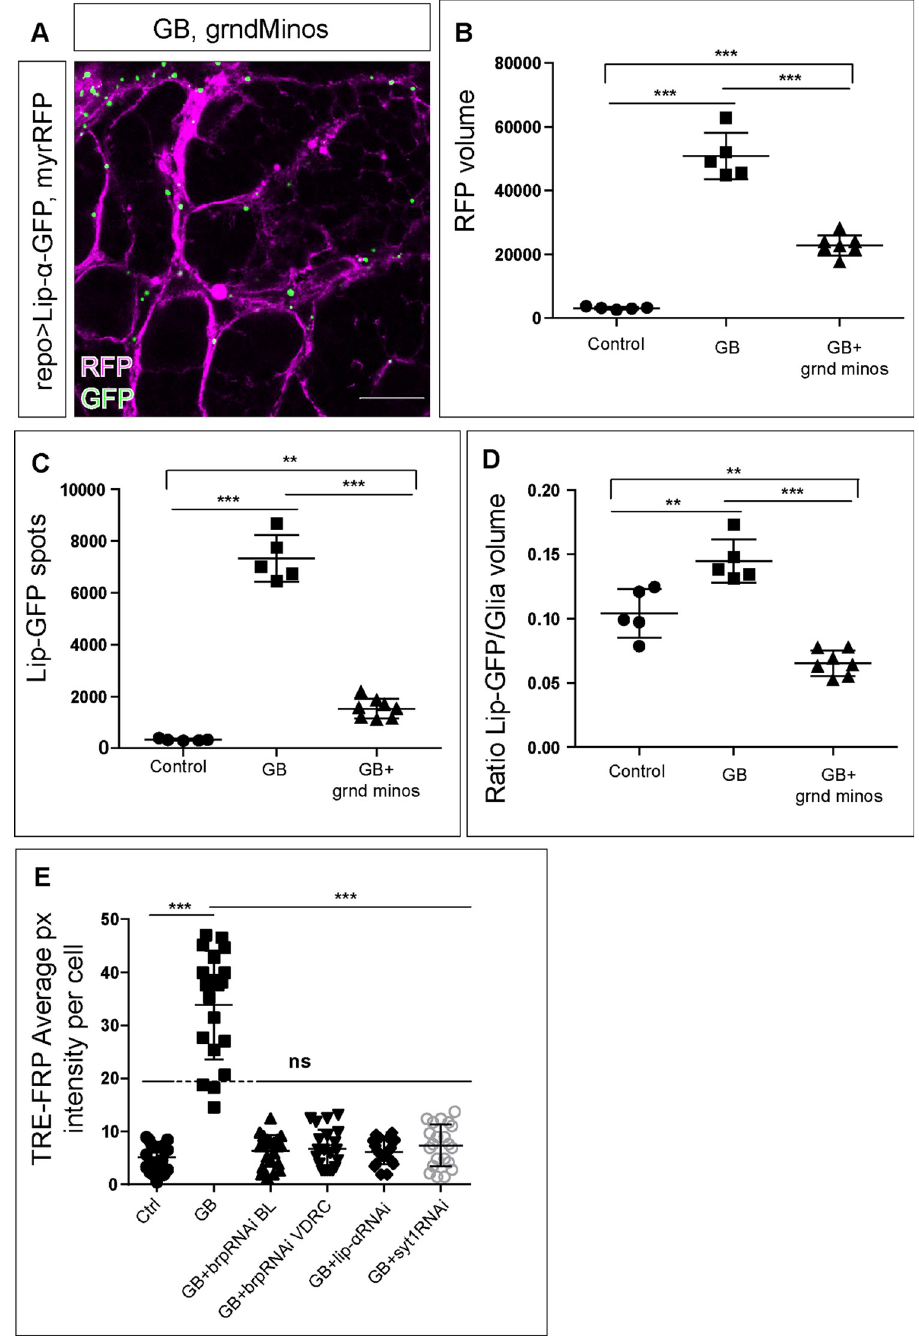
Fig 6. Presynaptic proteins are necessary for JNK upregulation in GB. A) Representative confocal images of Lip- α - GFP accumulation in the membranes of GB cells that express a dominant negative form of Grnd, grnd Minos . Lip-GFP is shown in green and GB membrane is shown in magenta. B) Quantification of glial membrane marked by mRFP in control brains, GB, and GB with grnd minos expressed in glia. No. � 5 animals. C) Quantification of Lip- α -GFP spots in control brains, GB, and GB with grnd minos expressed in glia. No. � 5 animals. D) Quantification of Lip- α -GFP signal normalized with glial membrane in control brains, GB, and GB with grnd minos expressed in glia. No. � 5 animals. Statistics in B-D: Bonferroni’s Multiple Comparison Test ( �� p < 0.001; ��� p < 0.0001) E) Quantification of TRE-FRP signal intensity per cell in control, GB, GB that expresses Brp lip- α or syt 1 RNAi . Statistics: Dunnett’s Multiple Comparison Test ( ��� p < 0.0001; ns = not significant). No. � 5 images from 5 brain lobes. Scale bar: 15 μ m. Raw numbers and complete genotypes are in S1 Table.